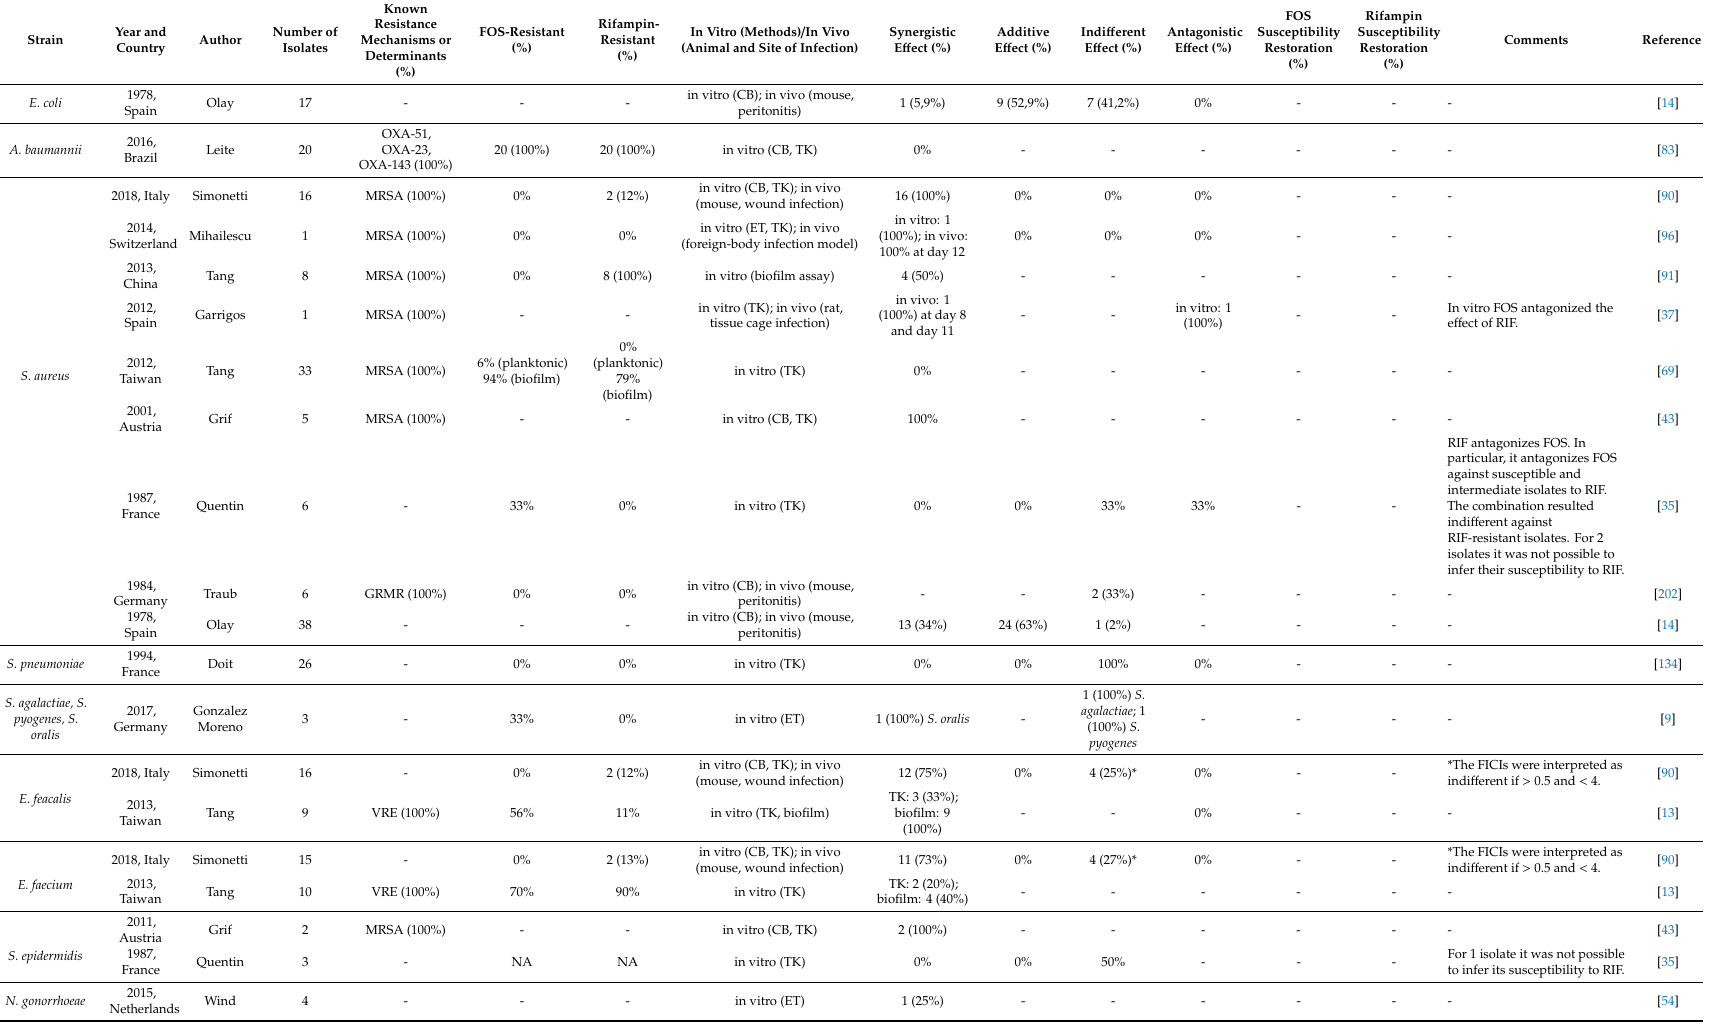
Table 14. Studies on combination between fosfomycin and rifampin. CB: checkerboard assay; TK: time–kill assay; ET: E-test.